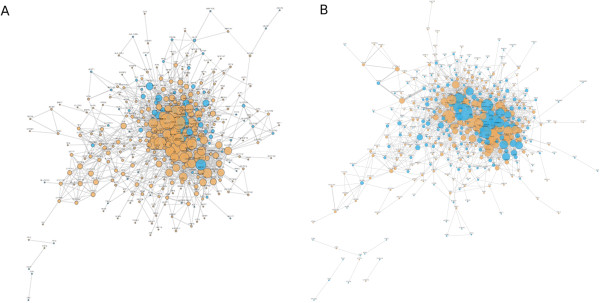
The gene interaction networks of diabetes mellitus and obesity (A) as well as bladder neoplasms and lung neoplasms (B). Orange nodes denote shared genes between the disorders. Even though the genetic overlap between the pairs is similar, the levels of mutual citation are significantly different.